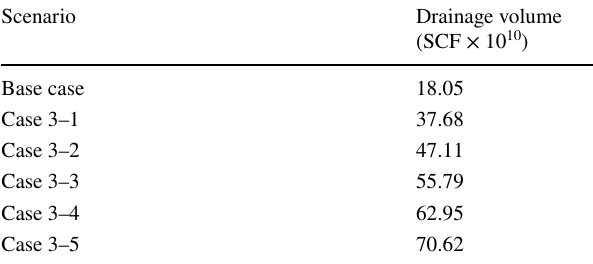
Table 15 DV from fracture half-length